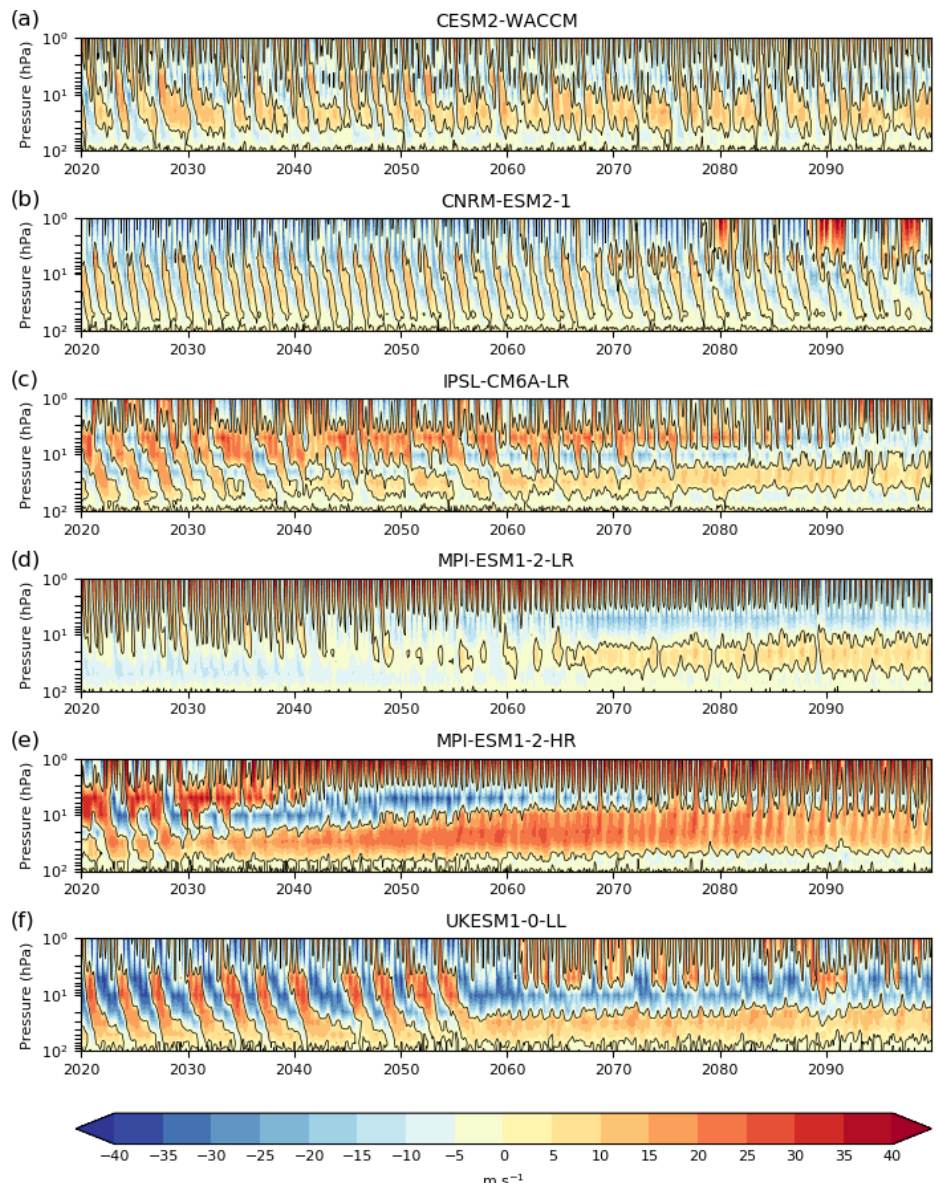
Figure 8. Same as Fig. 7a–f but from the first ensemble member of each model’s G6sulfur